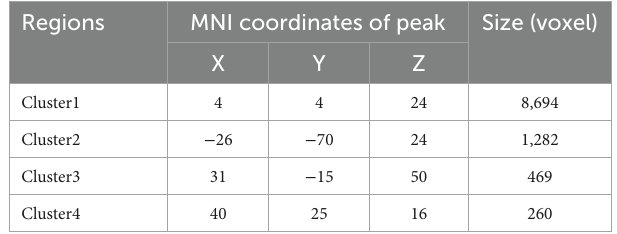
TABLE 3 The regions in the WM skeleton that negatively related to motion coherence threshold in older adults. Regions MNI coordinates of peak Size (voxel)